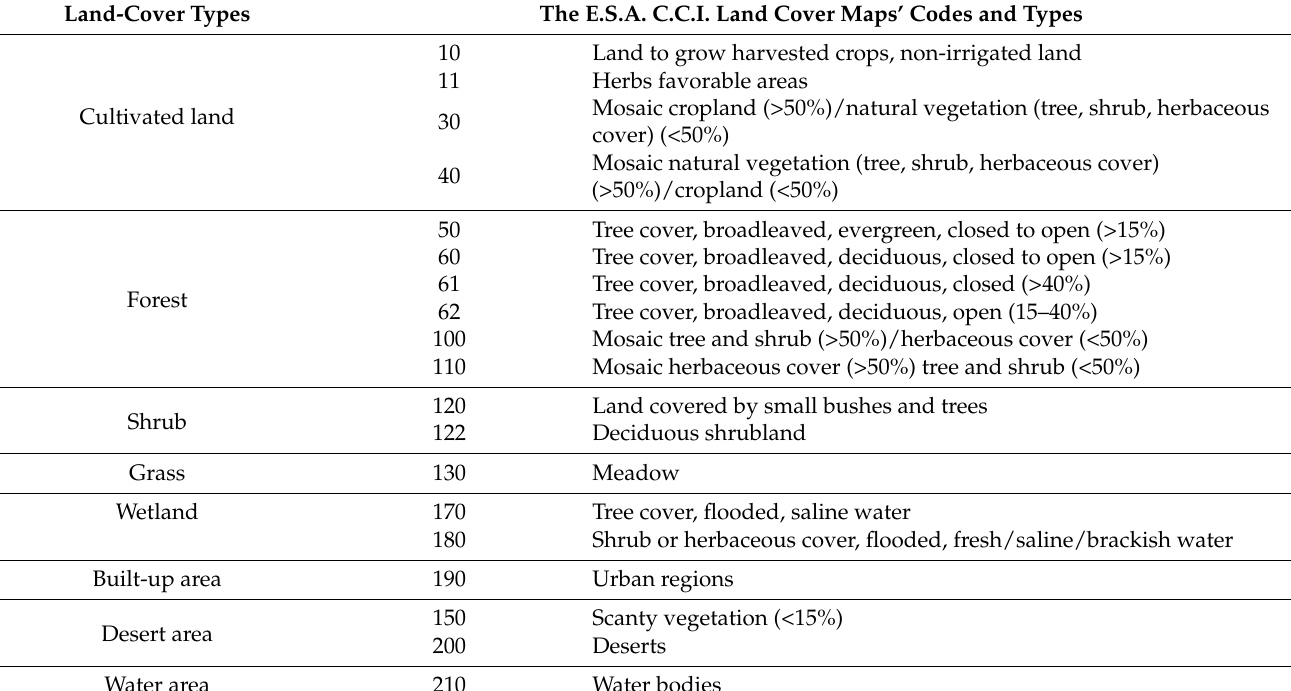
Table 1. The classification of Madagascar’s land cover.